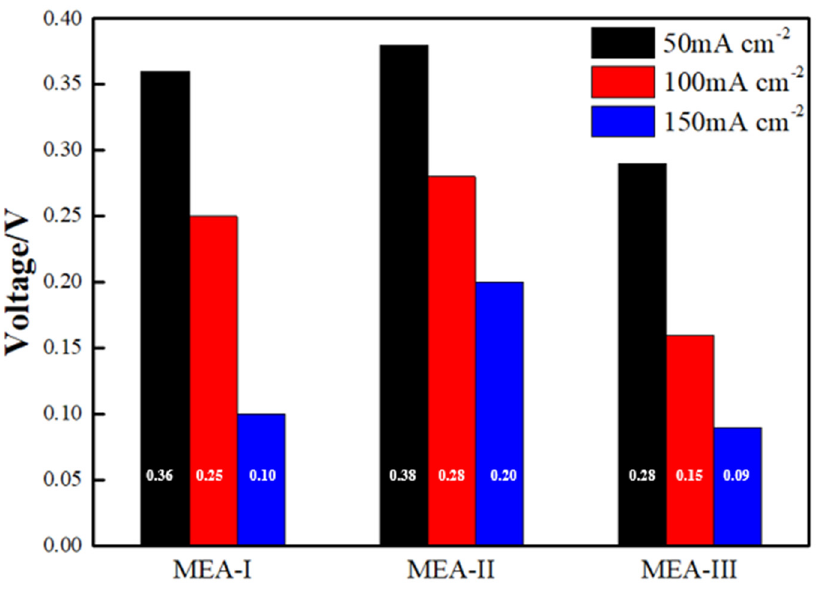
Figure 6. Voltage values corresponding to several current density points in the above polarization curves at 60 °C.